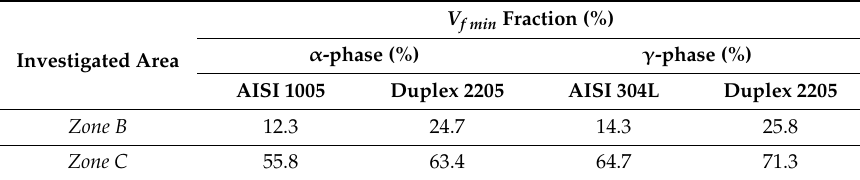
Table 3. V f min fractions estimated in α and γ -phase after different strain levels.